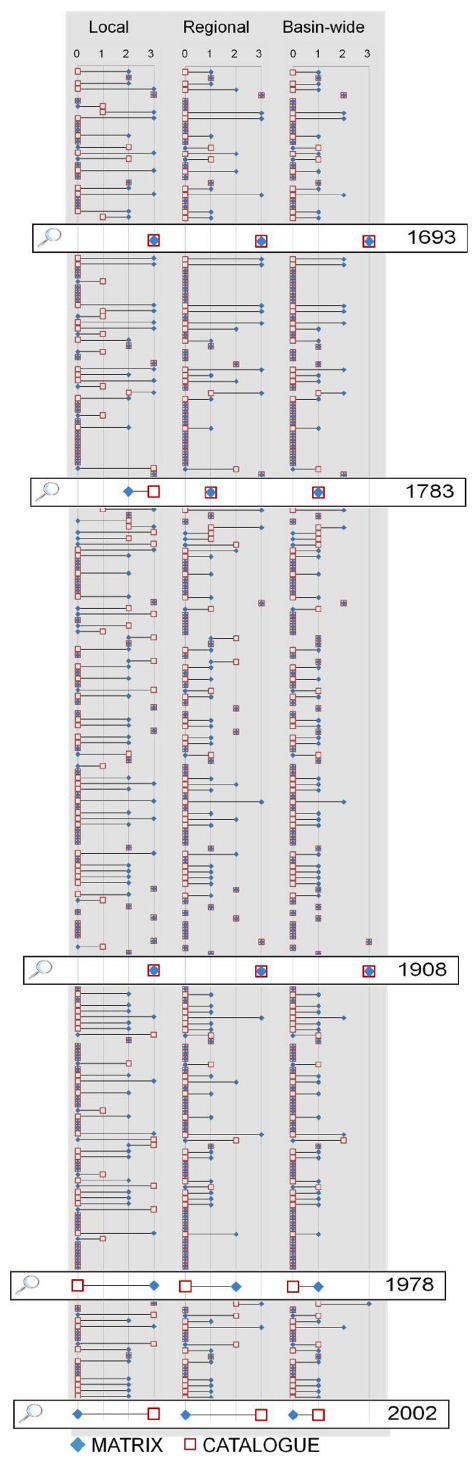
Fig. 7. Graph comparing DM and ITC actions in chronological order for all the 212 cases analysed. The longer the segment of a case, the larger the